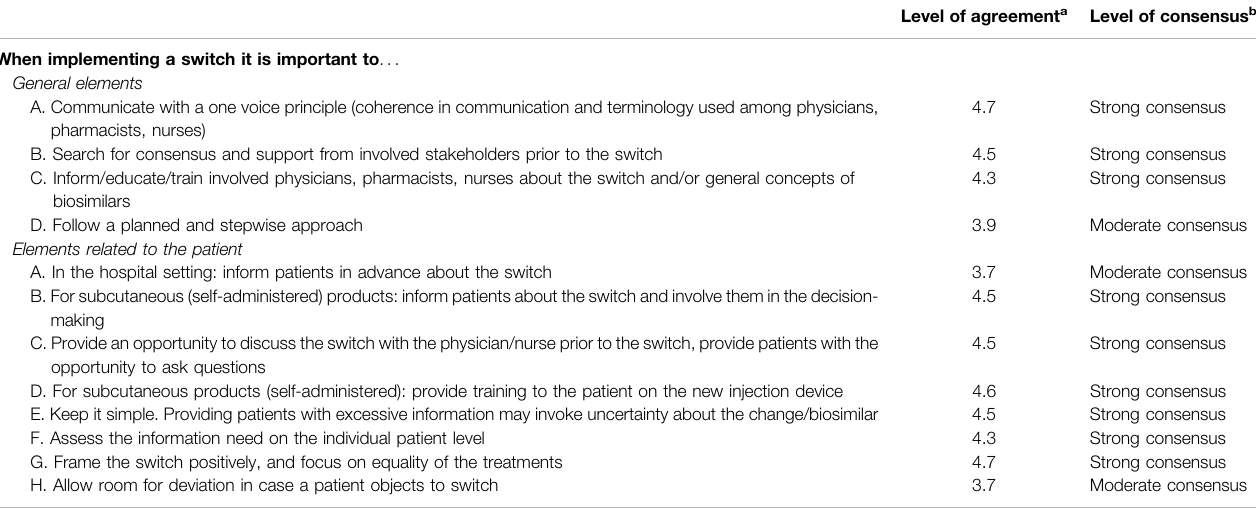
TABLE 3 | How to ef fi ciently manage a switch from a biological reference product to a biosimilar or vice versa and inform the patient: guiding principles from structured healthcare professional group discussions.